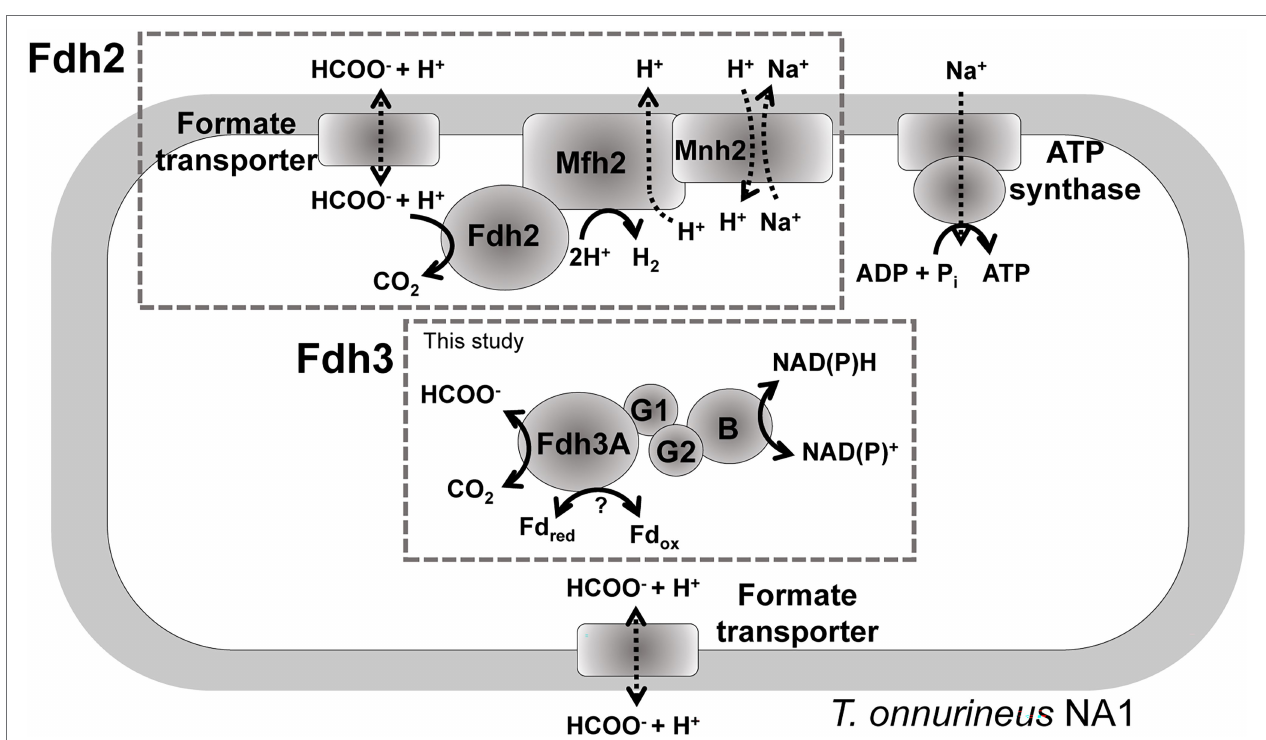
FIGURE 5 | A proposed model for the functional roles of Fdh2 and Fdh3. The schematic diagram does not represent the actual composition of each subunit of